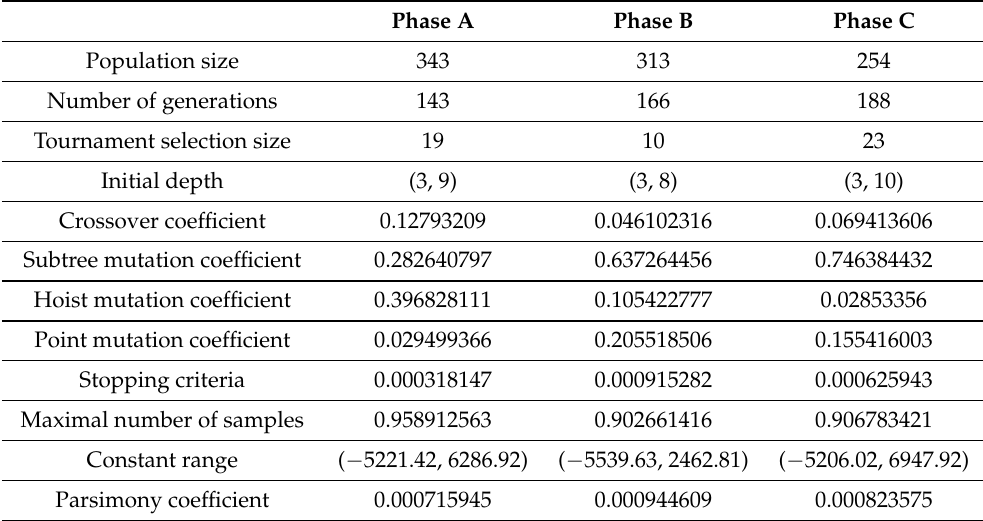
Table 4. The GPSR hyperparameters used for the definition of the symbolic expressions for phase voltage